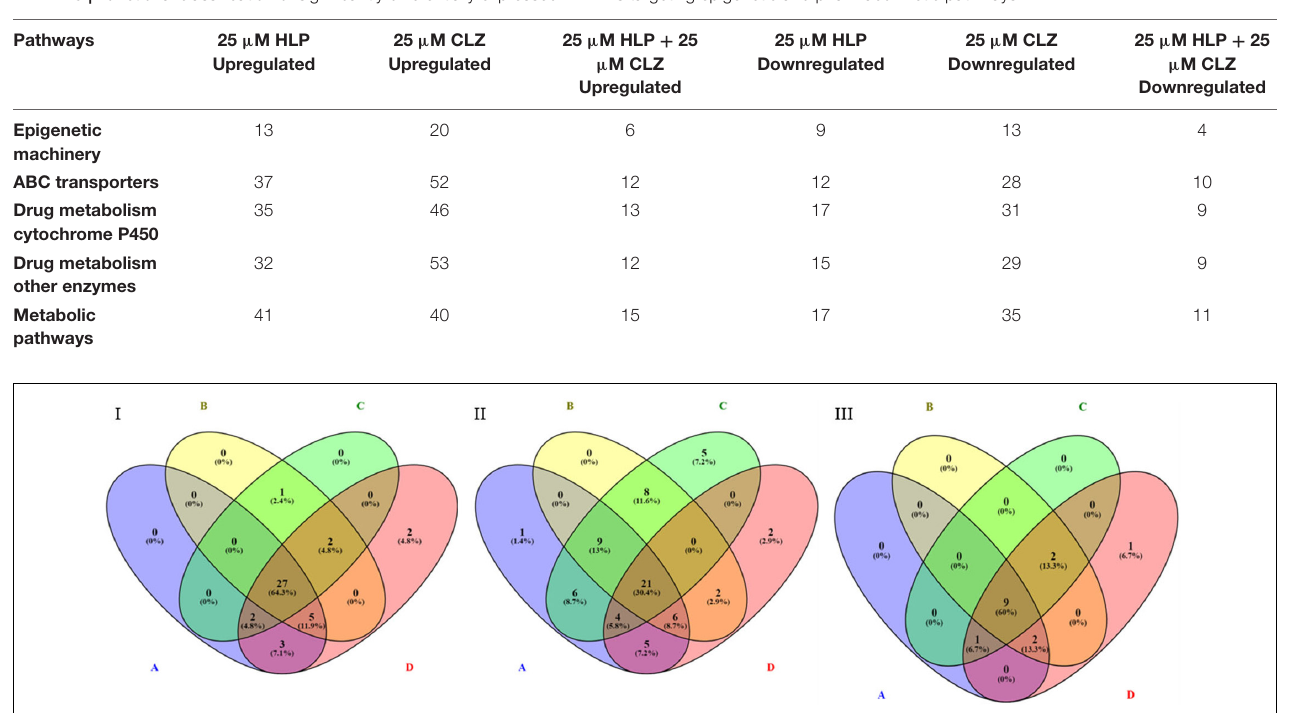
TABLE 5 | Functional classification of significantly differentially expressed miRNAs targeting epigenetic and pharmacokinetic pathways.